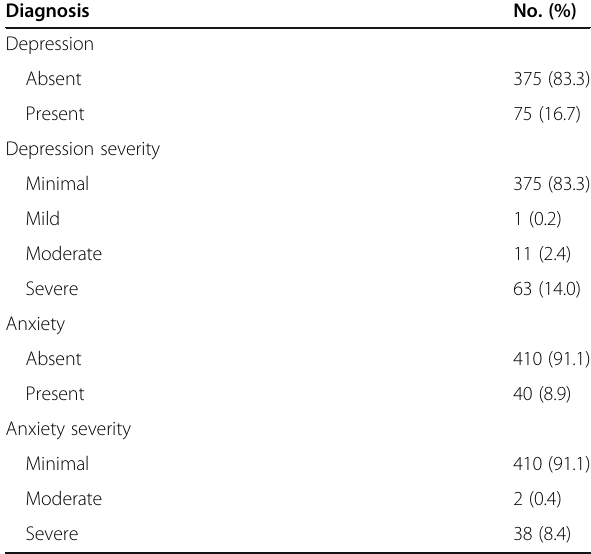
Table 2 Psychiatric diagnosis among the studied females